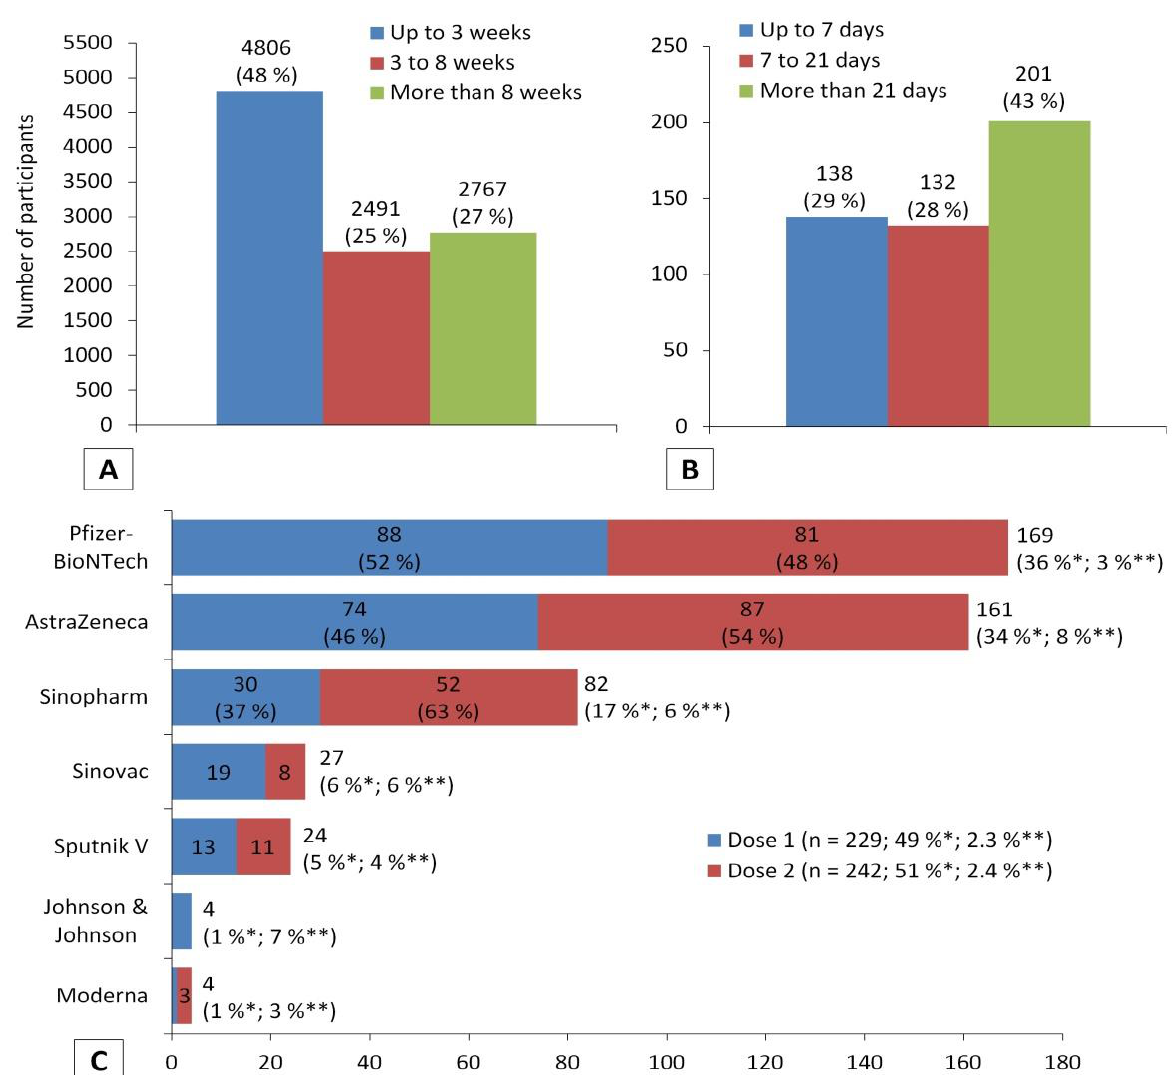
Figure 2. Participants’ post-vaccination information. ( A ) Interval between receiving a COVID-19 vaccine and participating in this study ( n = 10,064). ( B ) Time of COVID-19 vaccine breakthrough infection ( n = 471). ( C ) Characterization of participants who experienced COVID-19 vaccine breakthrough infections based on the type of vaccine and number of doses ( n = 471; 4.7%). * The perception was calculated out of the total number of participants who experienced vaccine breakthrough infection ( n = 471); ** the perception was calculated out of the total number of participants who received the vaccine (Table 3).